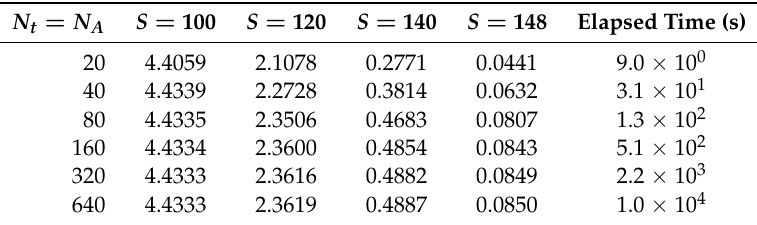
Table 2. V ( S ,0,0 ) evaluated by SABO at S = 100,120,140,148.